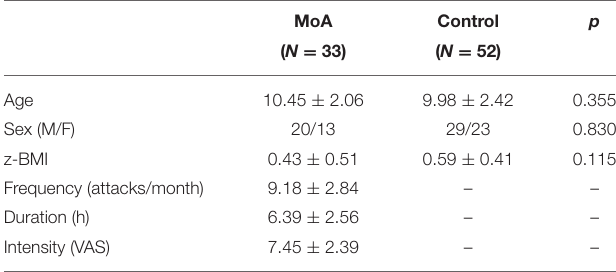
TABLE 1 | The comparison between migraine without aura (MoA) and typically developing children (Control) groups in age, sex distribution, and z -score Body Mass Index